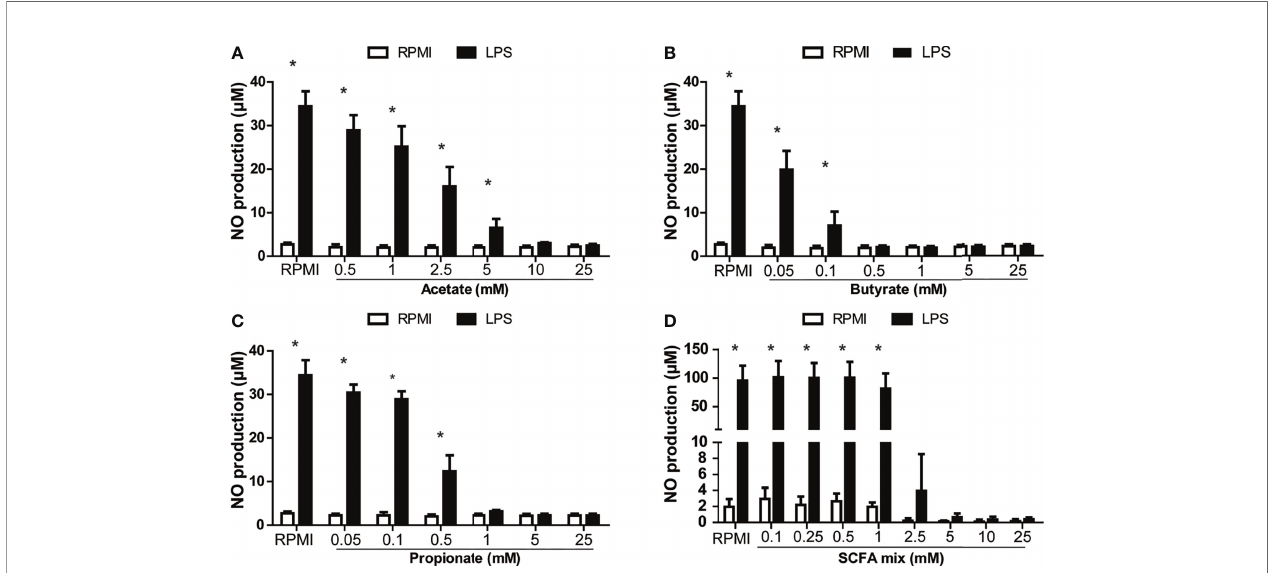
FIGURE 4 | SCFA reduced LPS-induced production of nitric oxide (NO) in head kidney leukocytes (HKL). Cells were stimulated with medium control (RPMI) or LPS (30 µg/ml) for 96 h in the presence or absence of the SCFAs, acetate, butyrate, or propionate or a mix in the relative proportion produced by in vitro fermenting MacroGard ® (62.5%/10%/27.5%, acetate/butyrate/propionate). (A) NO production of LPS-stimulated HKL in the presence of acetate. (B) NO production of LPS- stimulated HKL in the presence of butyrate. (C) NO production of LPS-stimulated HKL in the presence of propionate. (A – C) Bars indicate mean ± SD of n = 3 independent experiments. (D) NO production of LPS-stimulated HKL in the presence of SCFA mix, indicating that the concentration is determined by the total amount of acetate, butyrate, and propionate (25 mM (15.625 mM acetate/2.5 mM butyrate/6.875 mM propionate). Bars indicate mean ± SD of n = 5 independent experiments. Note the difference in scale for the Y-axis in (D) . Asterisk (*) indicates signi fi cant difference between NO production induced in the presence (solid black bars) or absence of LPS (open white bars) assessed by the linear mixed model followed by the Bonferroni post hoc test.